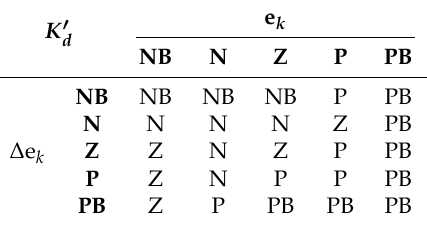
Table 3. Fuzzy tuning rules for K (cid:48)